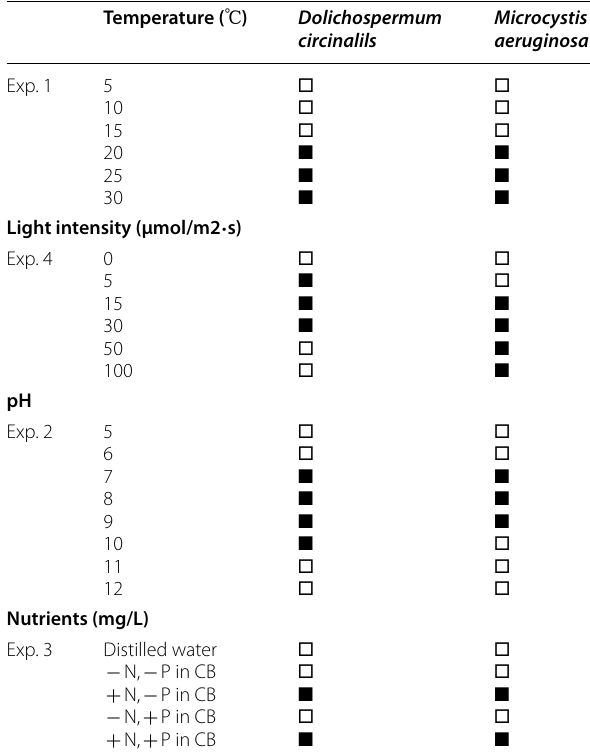
high water temperature (Kanoshina et al. 2003; Hong et al. Table 3 Duplicated experiments at different temperature,